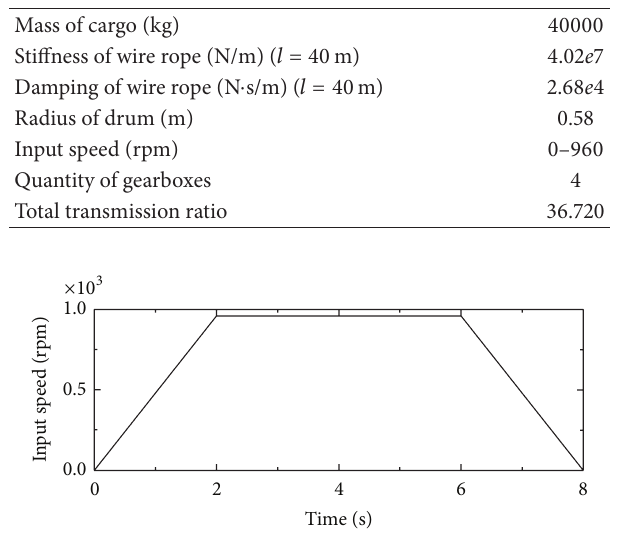
Figure 5: Input speed of gear transmission system in rising working condition.